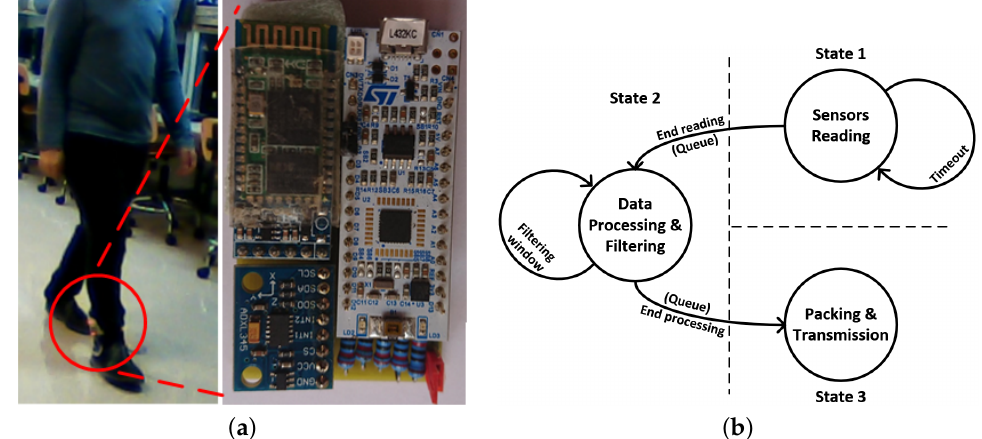
Figure 1. Wearable acquisition device: ( a ) wearable device placed in the ankle; ( b ) firmware’s state